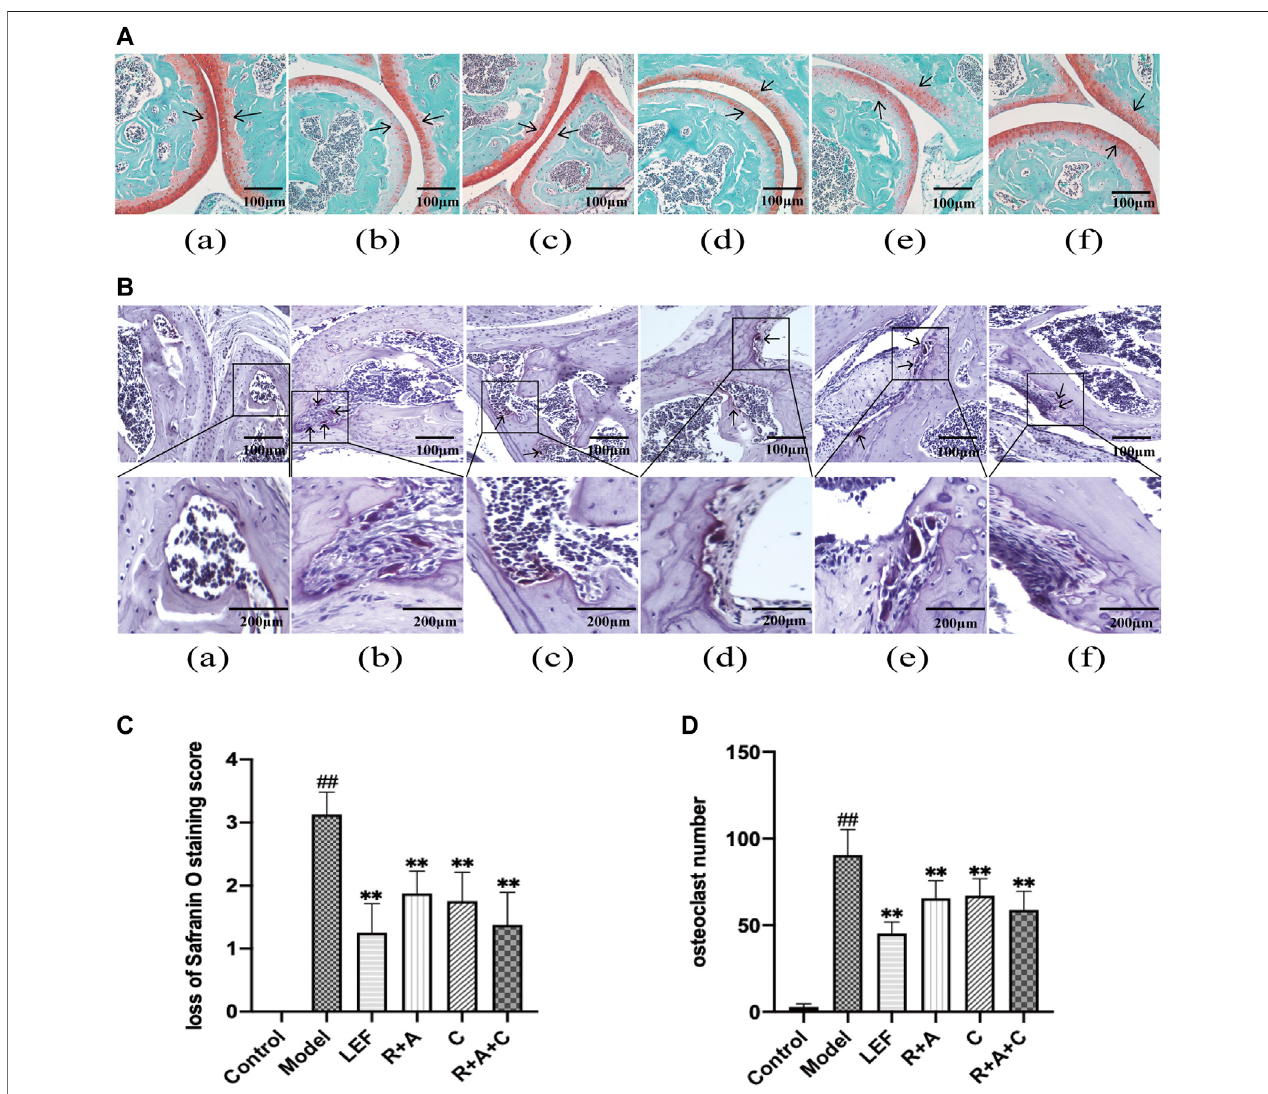
FIGURE 3 | The combination of three herbs improved bone destruction in CIA mice. (A) Saffron O staining of articular tissue (magni fi cation ×200). The arrow indicates articular cartilage. (B) Tartrate-resistant acid phosphatase (TRAP) staining of articular tissue (magni fi cation of the fi rst row ×200). The arrow points to osteoclasts. (C) score of loss of safranin O staining. (D) number of osteoclasts. (a) , control group; (b) , model group; (c) , LEF group; (d) , R . astragali + R . angelicae sinensis (R+A)group; (e) , C . lonicerae (C)group;and (f) , R . astragali + R . angelicaesinensis + C . lonicerae (R+A+C)group.Alldataareshownasmean±SD( n = 8); # p < 0.05, ## p < 0.01, compared with the normal group; * p < 0.05 ** p < 0.01, compared with the model group. The scale bar corresponds to 100 µm or 200 µm.